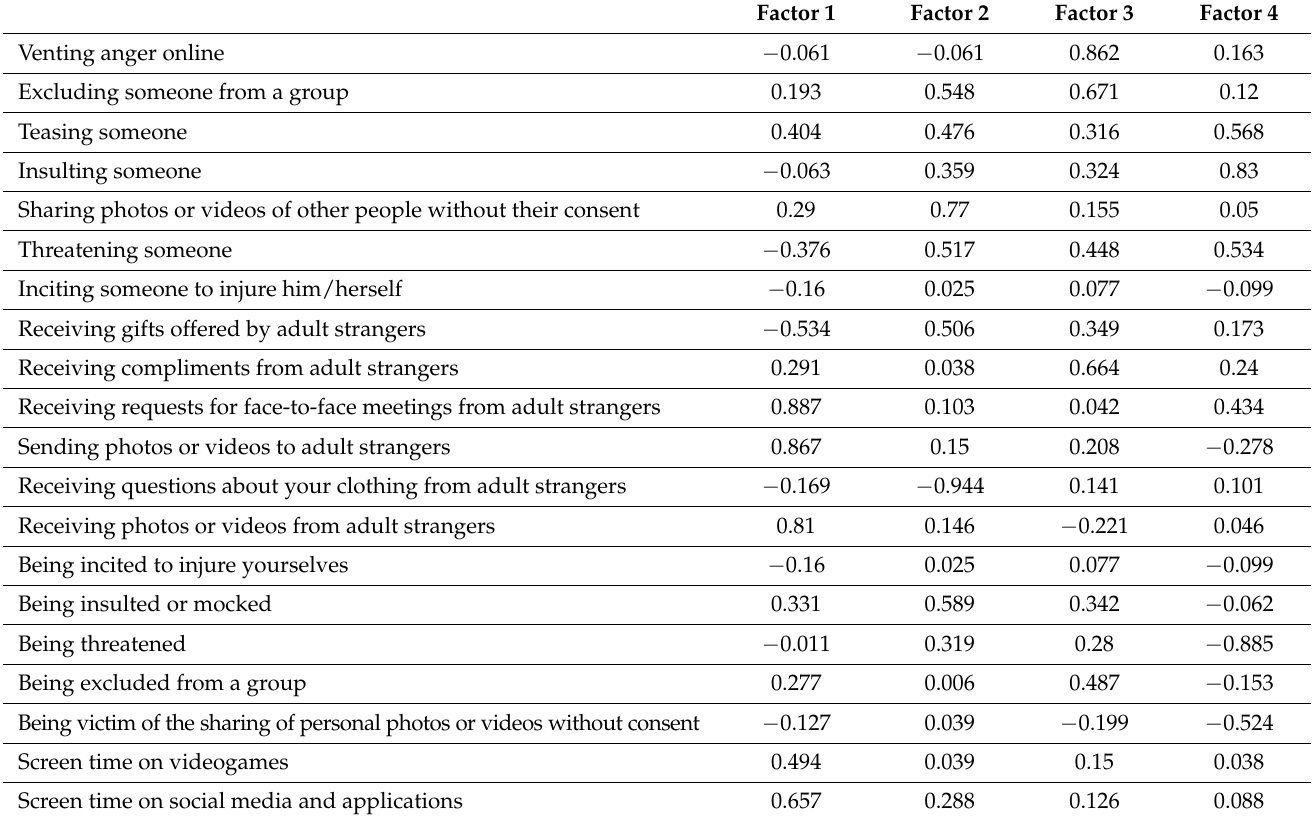
Table 1. Factor loadings for input